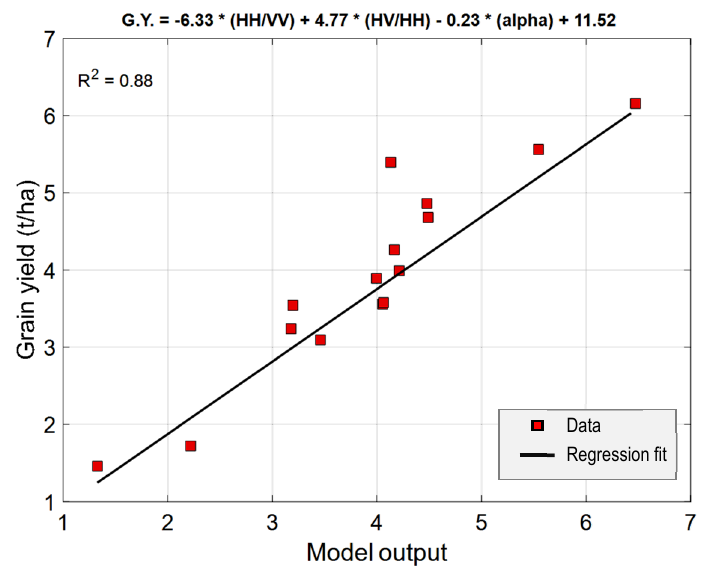
Figure 5. The model calibration. Figure 5. The model